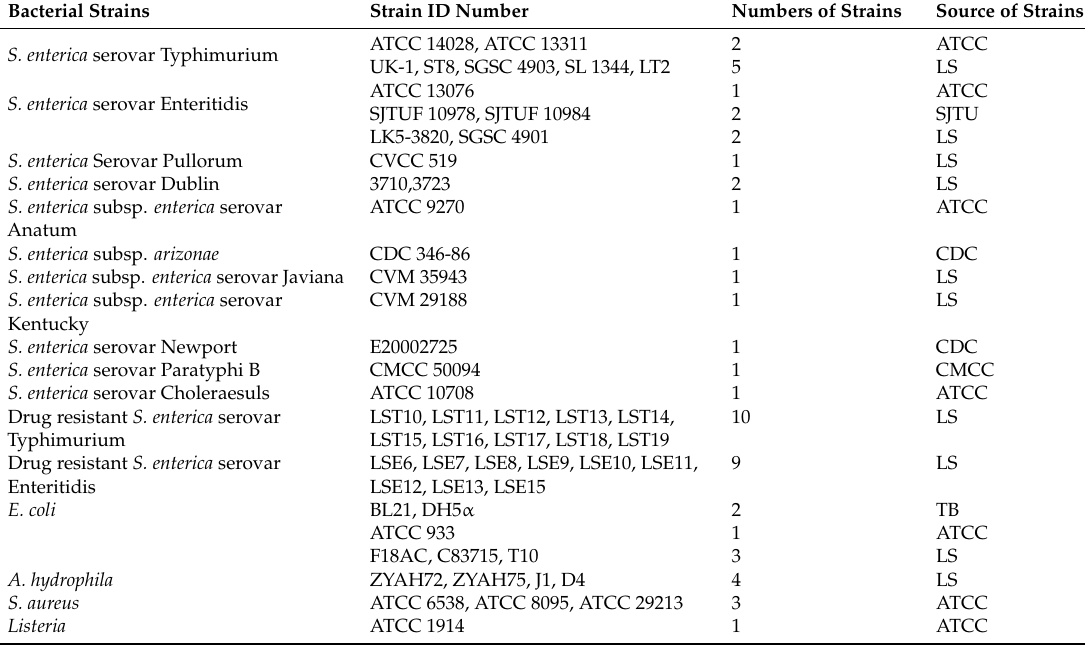
Table 1. List of bacterial strains used in this